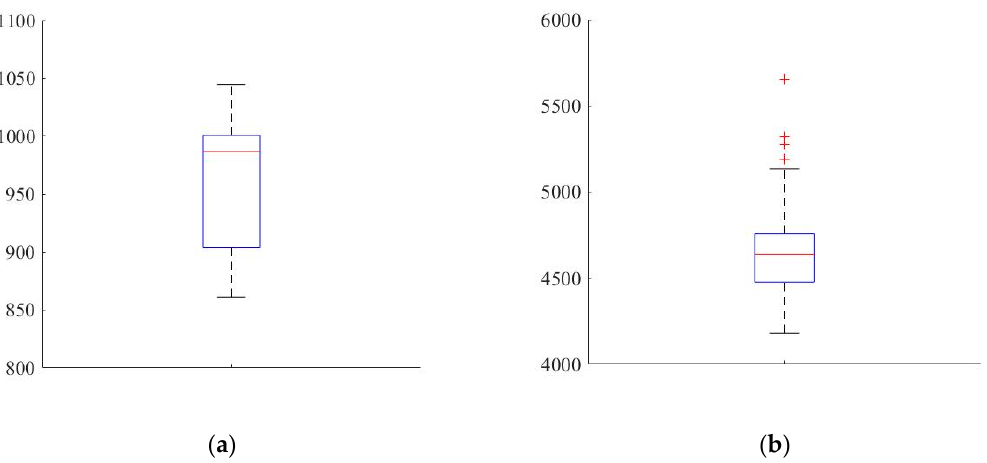
Figure 3. The statistical results of the total computational time for all 100 scenarios by the genetic algorithm (GA). ( a ) H-95 with p = 10; ( b ) C-668 with p = 10.